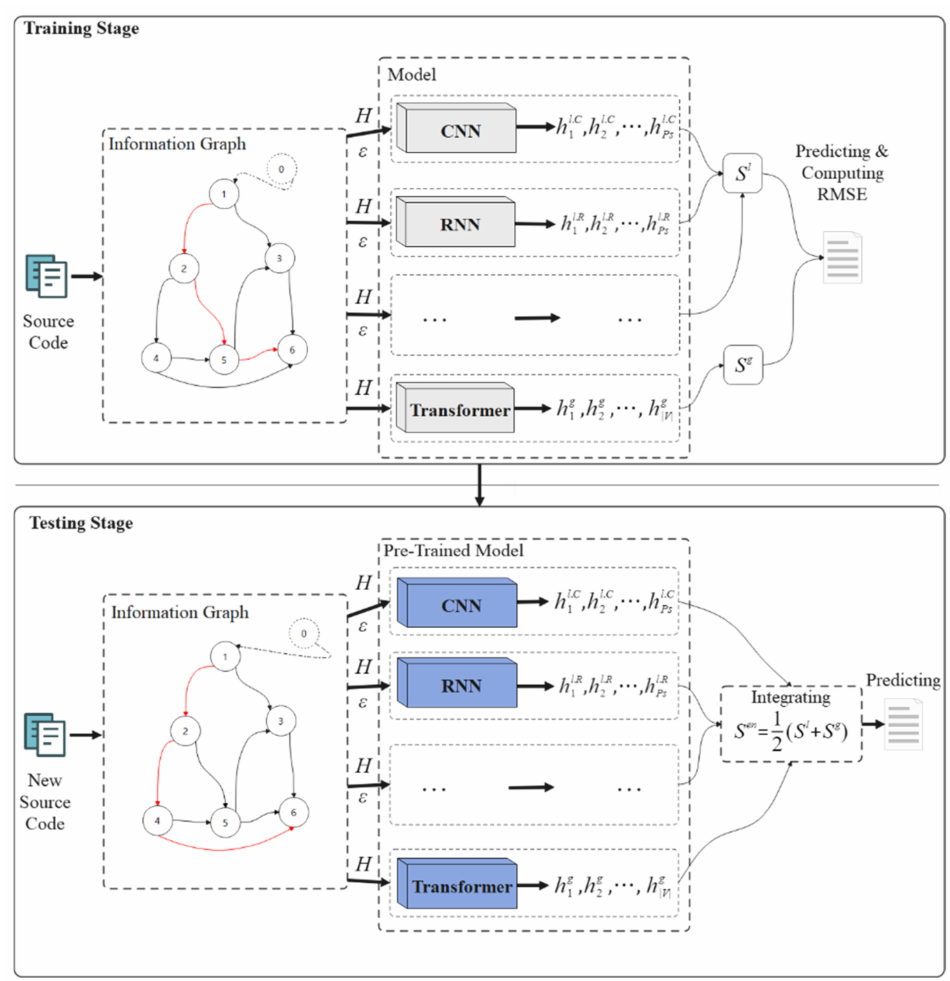
Figure 1. SCVDIE